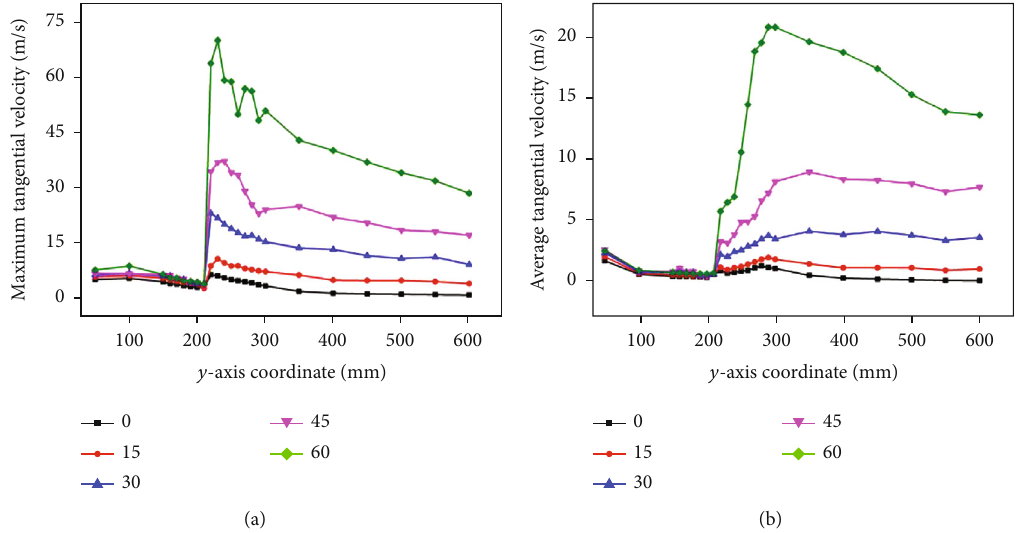
Figure 9: Variations in air velocity at di ff erent cross-sections along central passage of drill bit without fl ushing nozzles: (a) maximum tangential velocity; (b) average tangential